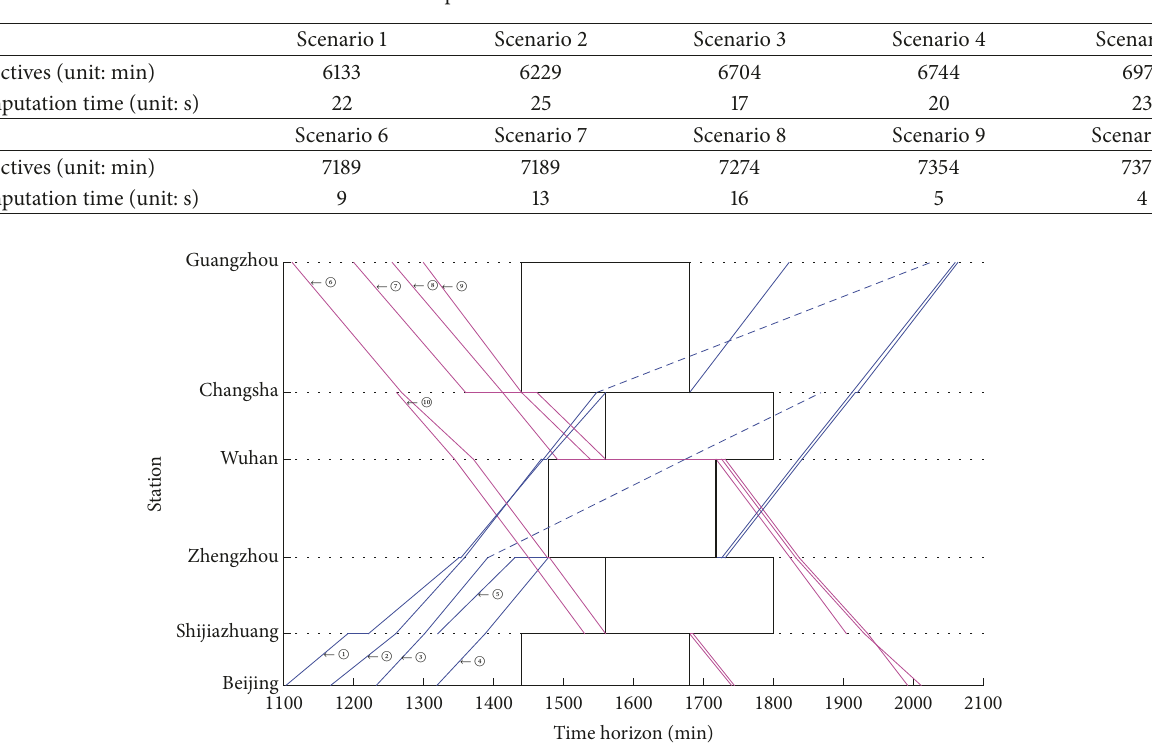
Table 7: Computational results under different scenarios.